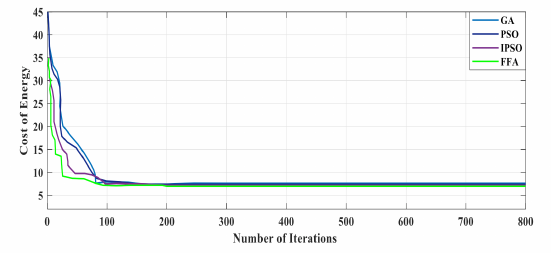
Fig. 9. Convergence characteristics of Cost of Energy